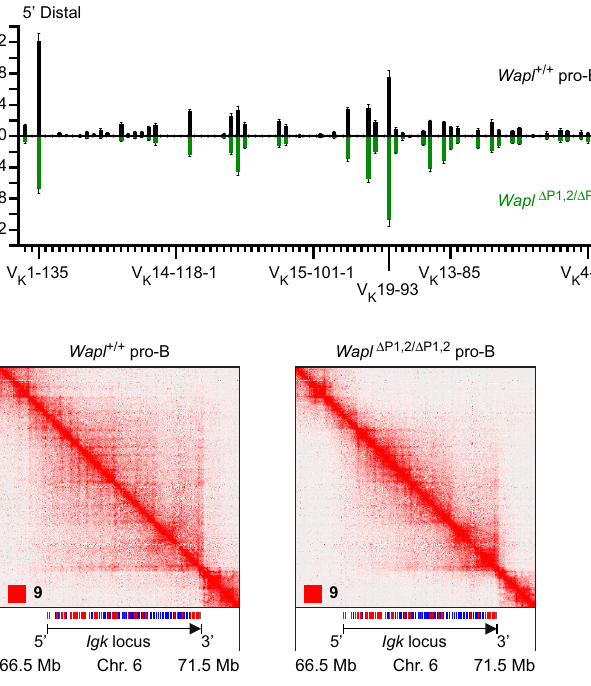
Fig. 4 | V K -J K recombination atthe Igk locus in Wapl high and Wapl low pro-B cells. a V K gene recombination analysis of ex vivo sorted Wapl +/+ (Wapl low ; black) and Wapl Δ P1,2/ Δ P1,2 (Wapl high ; green) pro-B cells, as determined by VDJ-seq experiments. The recombination frequency of each V K gene is indicated as a percentage of all V K -J K rearrangement events and is shown as a mean value with SEM based on six independent VDJ-seq experiments for each pro-B cell type. The different V K genes (horizontal axis) are aligned according to their position in the Igk locus 25 (Supple- mentary Data 1a). Statistical data were analyzed by multiple t -tests (unpaired and two-tailed) with Holm – Sidak correction; * P <0.05, ** P <0.01, *** P <0.001. b Hi-C contact matricesofthe Igk region on chromosome6 based on published Hi-C